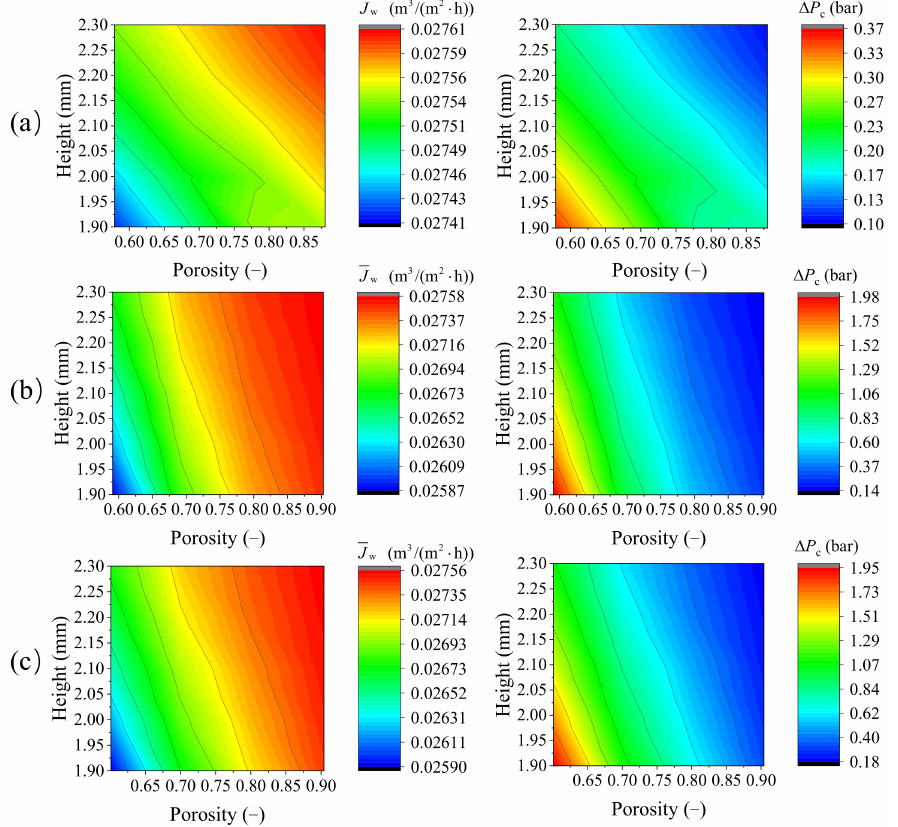
Figure 14. The total pressure drop, ∆ P c (bar), and average permeation flux of water, J w (m 3 /(m 2 · h)), for feed channels with different height and porosity filled with ( a ) CLP, ( b ) IWP, and ( c ) D based on TPMS,